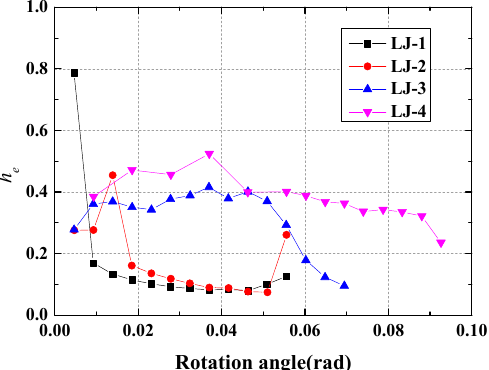
Figure 25. Equivalent viscous damping coefficient.